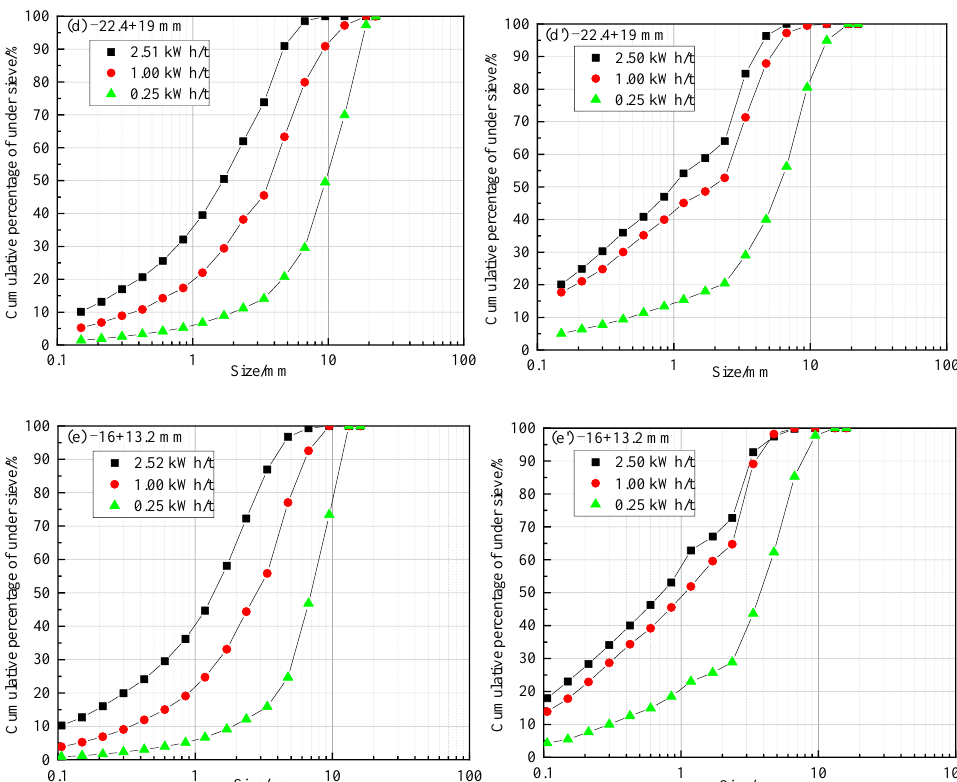
Figure 3. Particle size distribution from breakage product of different fractions. (( a – e ) are for Tongkeng ore; ( a ’– e ’ ) are for Gaofeng ore).